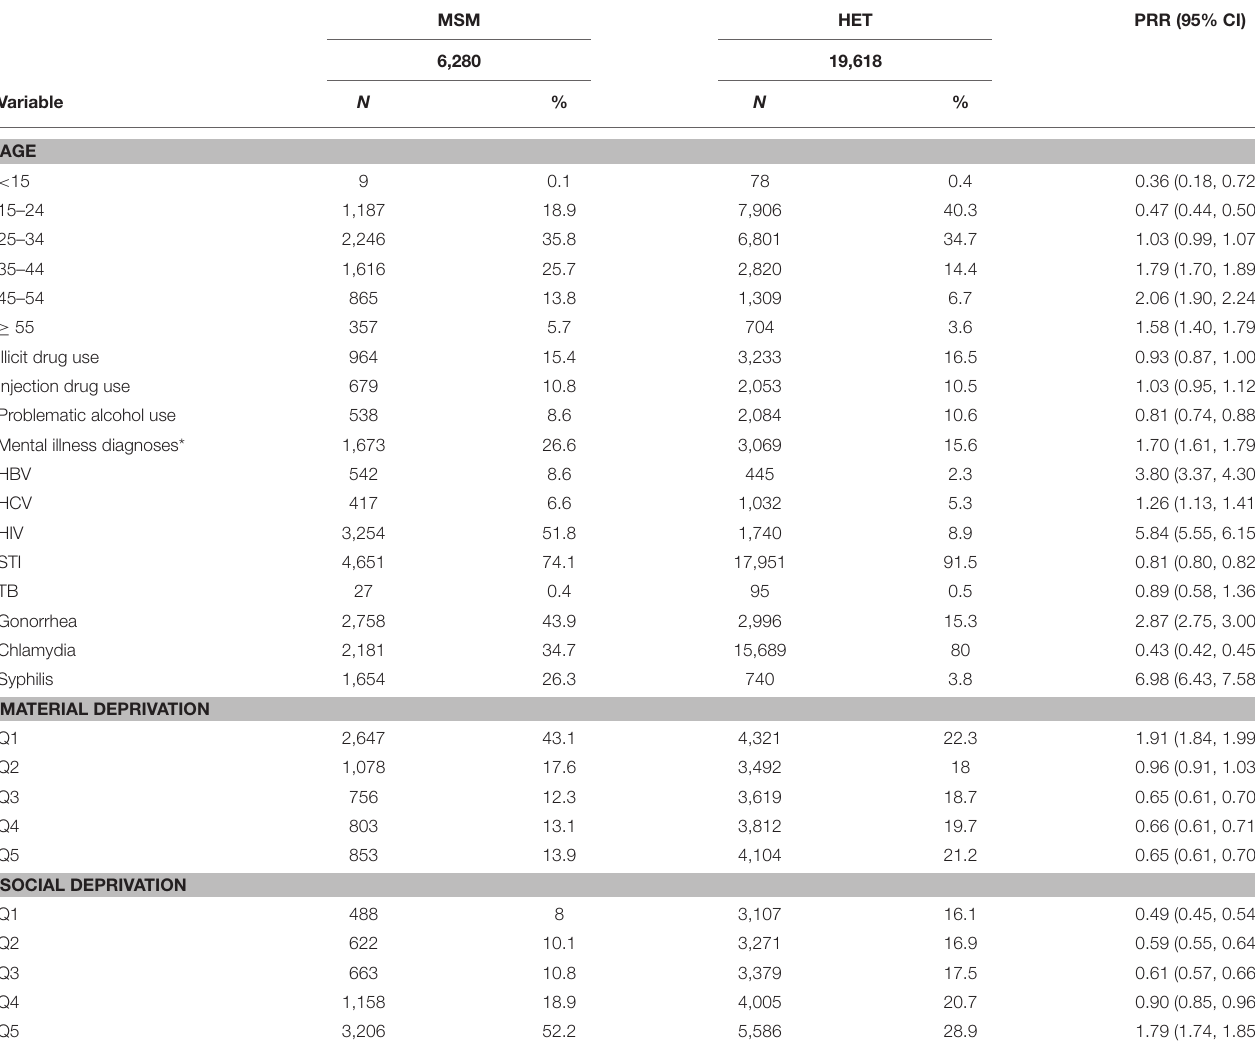
TABLE 2 | Characteristics of self-reported men who have sex with men and heterosexual men, HIV, hepatitis, and sexually transmitted infection surveillance case reports, British Columbia, 1980–2015.